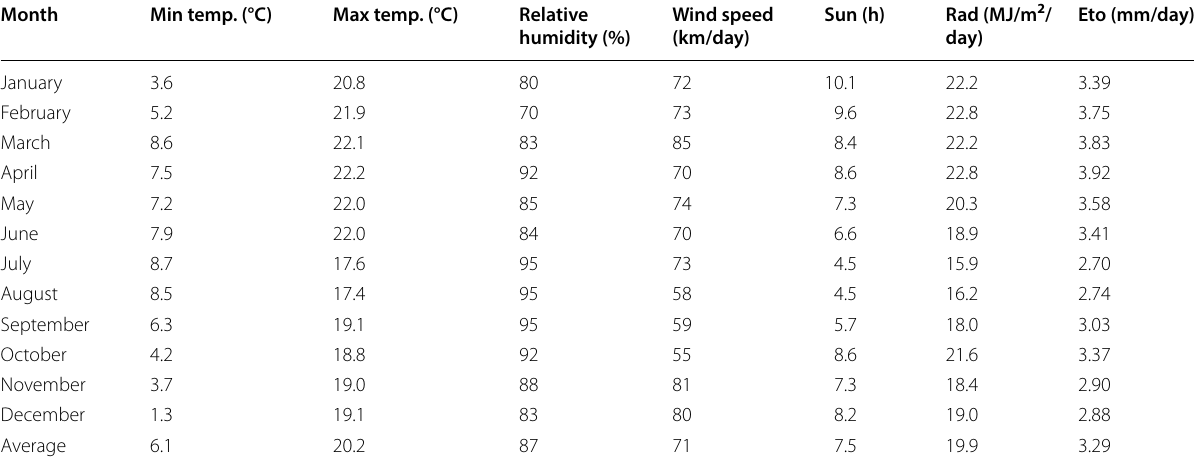
Table 1 Monthly reference evapotranspiration (Eto)